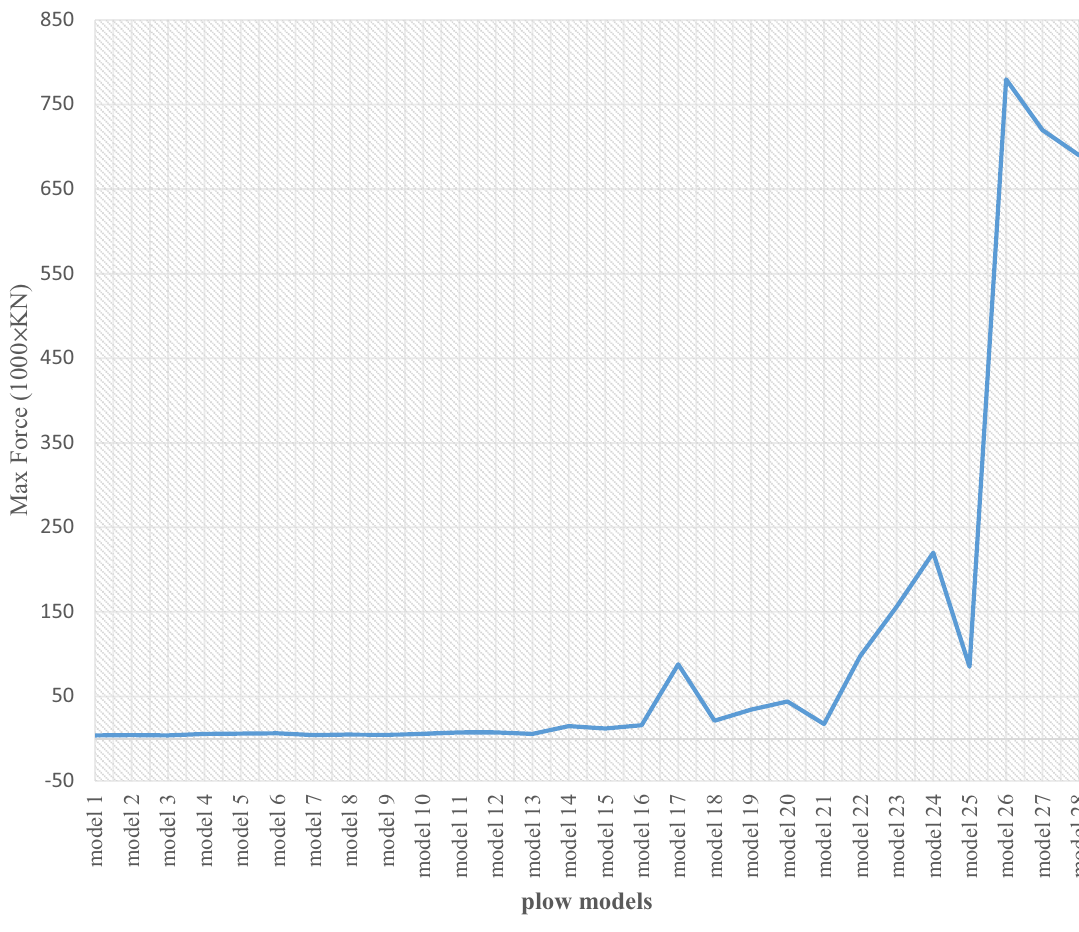
Fig. 21 Diagram of variations in maximum force applied to